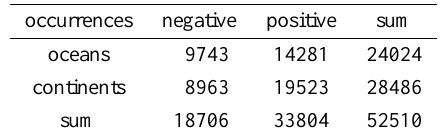
Table 1. The total numbers of negative and positive oceanic light- ning discharges during April 1998 are compared to continental lightning discharge occurrences